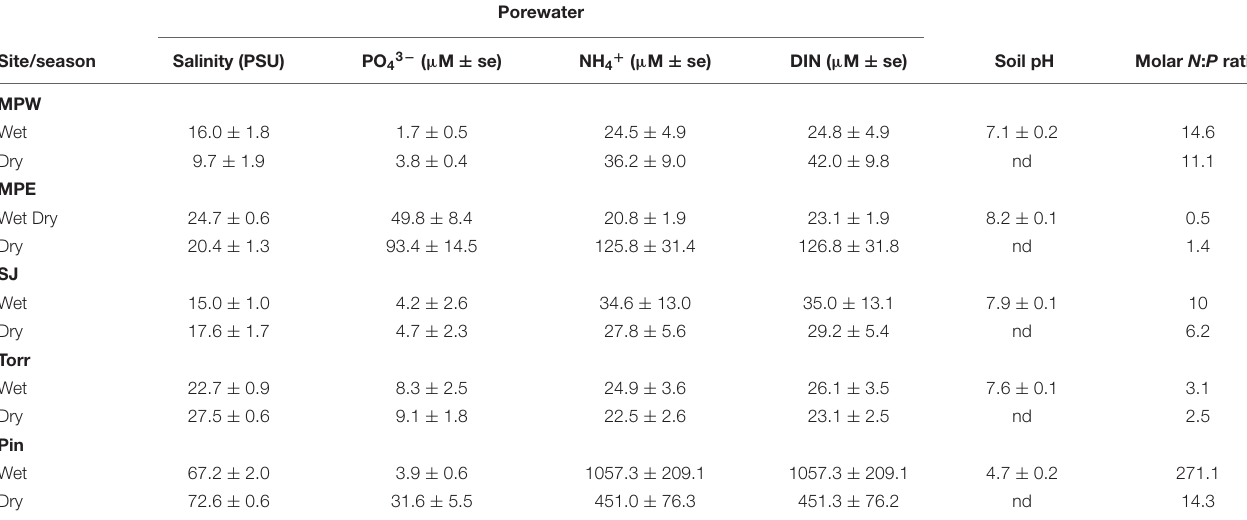
TABLE 1 | Porewater salinity and nutrient concentrations and soil pH (mean ± standard error) at mangrove sites in the wet (June 2016) and dry (February 2017) seasons in the San Juan Bay Estuary.